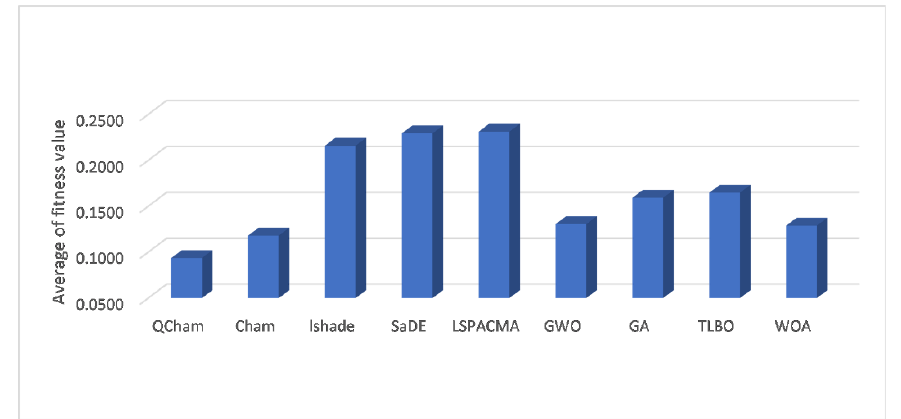
Figure 2. Fitness value mean of all the investigated datasets. Table 4. Best fitness values for QCham and